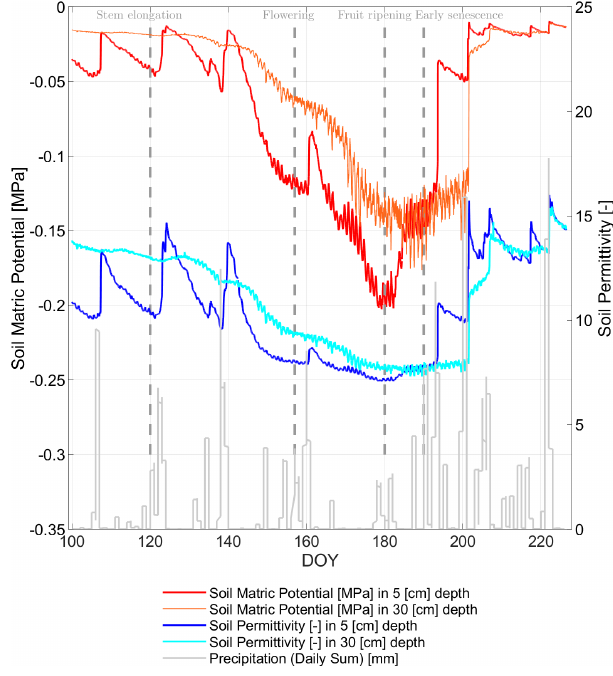
Figure 9. Comparison of the temporal evolution of soil matric po- tential (SMP) [MPa], calculated after Campbell (1974) and Clapp and Hornberger (1978) in 5[cm] (red curve) and 30[cm] (orange curve) soil depth from in situ-measured soil permittivity [–] in 5[cm] (blue curve) and 30[cm] (cyan curve) throughout growing season of 2017 in days of year (DOY). Gray bars indicate the daily sum of precipitation [mm] at the winter wheat field in Selhausen, Germany.